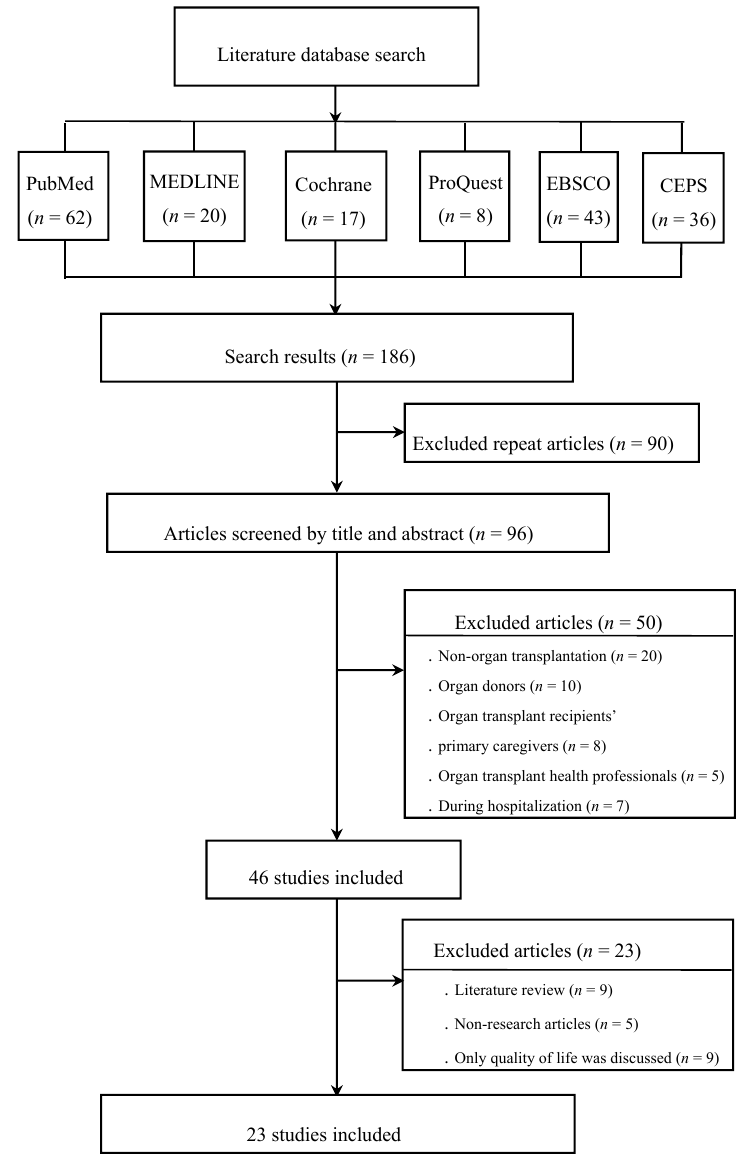
Figure 1. Preferred Reporting Items for Systematic Reviews and Meta-Analyses (PRISMA) flow diagram: results of the literature search and selection.